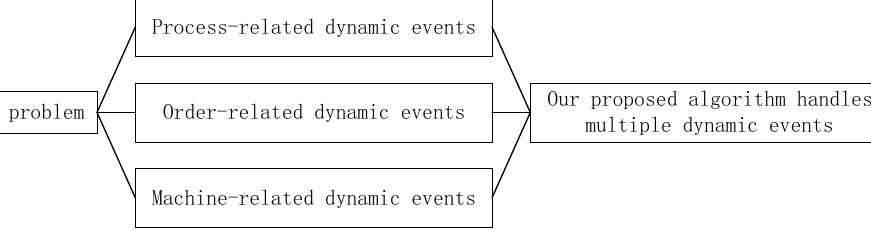
Figure 1. Differences between relevant works and our